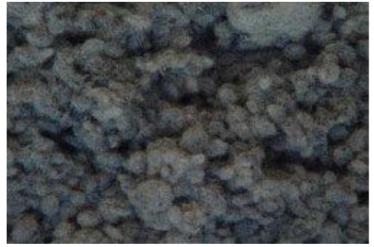
Figure 1. Resultant fibers after recycling